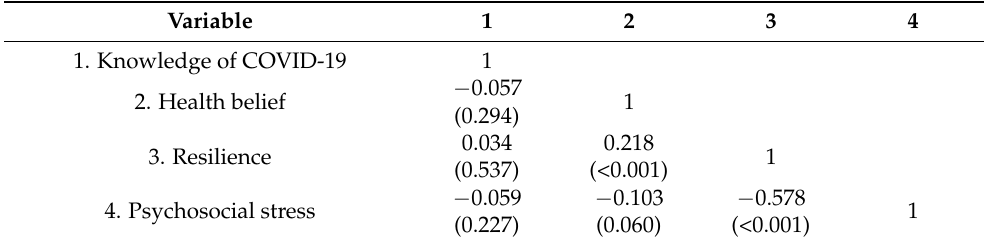
Table 3. Correlations between participants’ scores for knowledge of COVID-19, health belief, re- silience, and psychosocial stress.